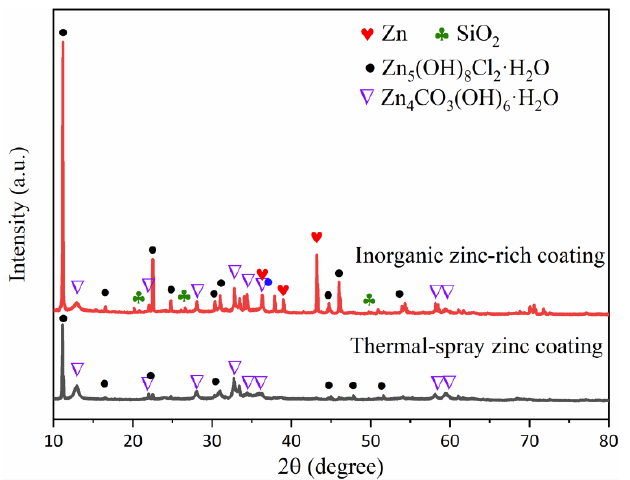
Figure 15. XRD patterns of the thermal-spray zinc coating and inorganic zinc-rich coating after 7500 h of salt spraying. of salt